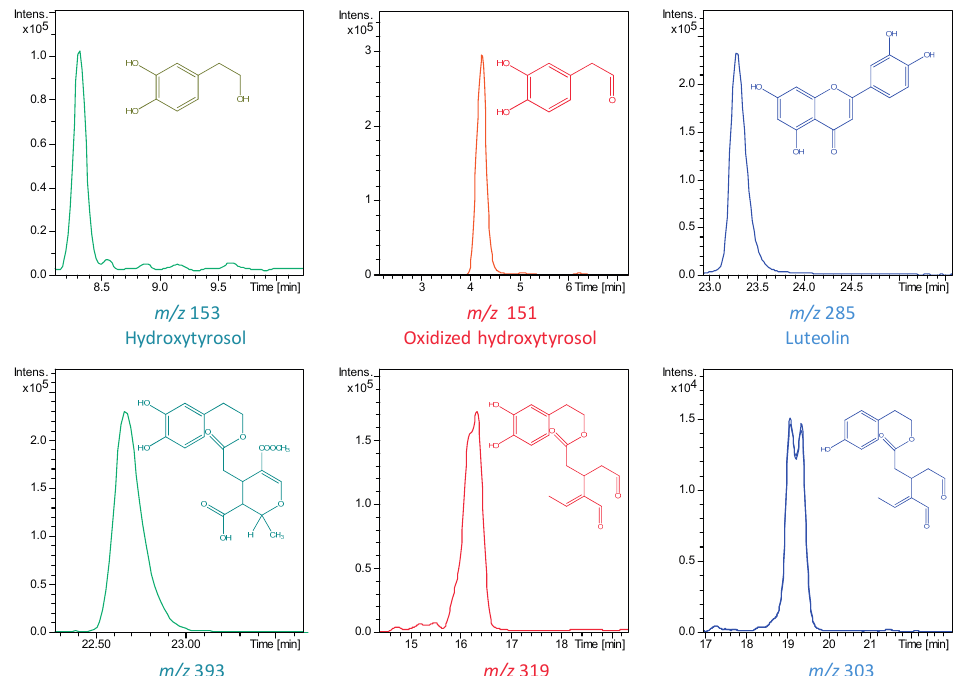
Figure 2. Extracted ion chromatograms (EIC) of some phenolic compounds characterized by high-performance liquid chromatography electrospray time-of-flight mass spectrometry